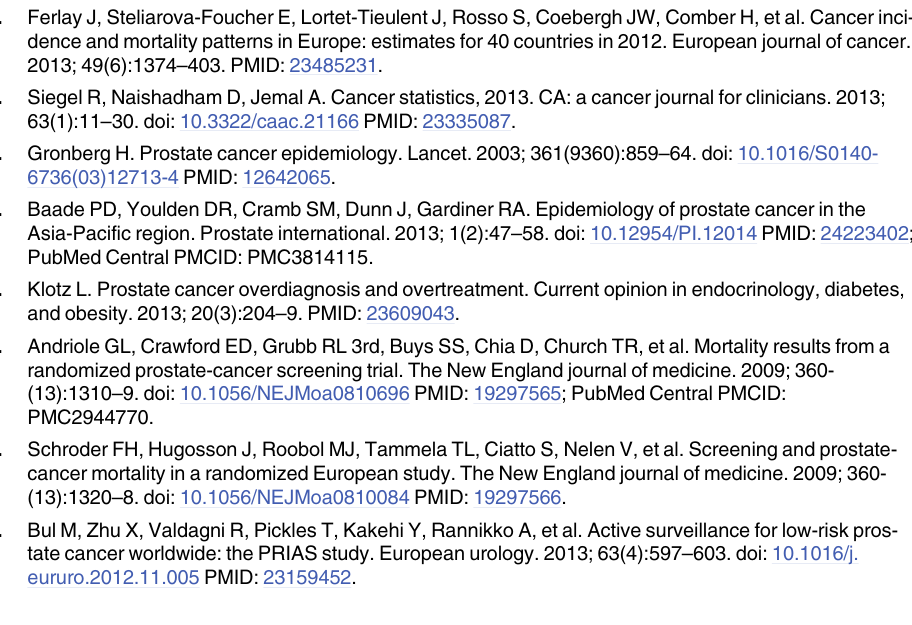
S2 Fig. Extracapsular extension of prostate cancer was one of the strong predictor of pros- tate-specific antigen recurrence. Prostate-specific antigen-free survival periods were com- pared between organ-confined disease (pT2) and extracapsular extension (pT3 and pT4). Survival was analyzed by Kaplan-Meier curves.